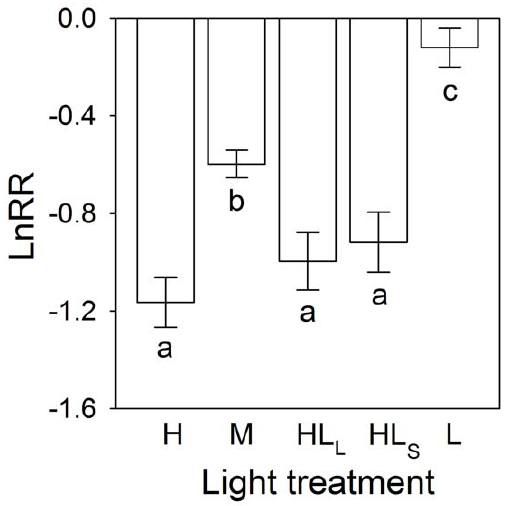
Figure 3. Effects of light treatment on competition intensity of Duchesneaindica . The competition intensity was measured by the log response ratio (LnRR) of biomass of the whole clone. Bars are mean values ( + SE). Bars sharing the same letters are not different at P =0.05. Treatment codes are in Figure 1.